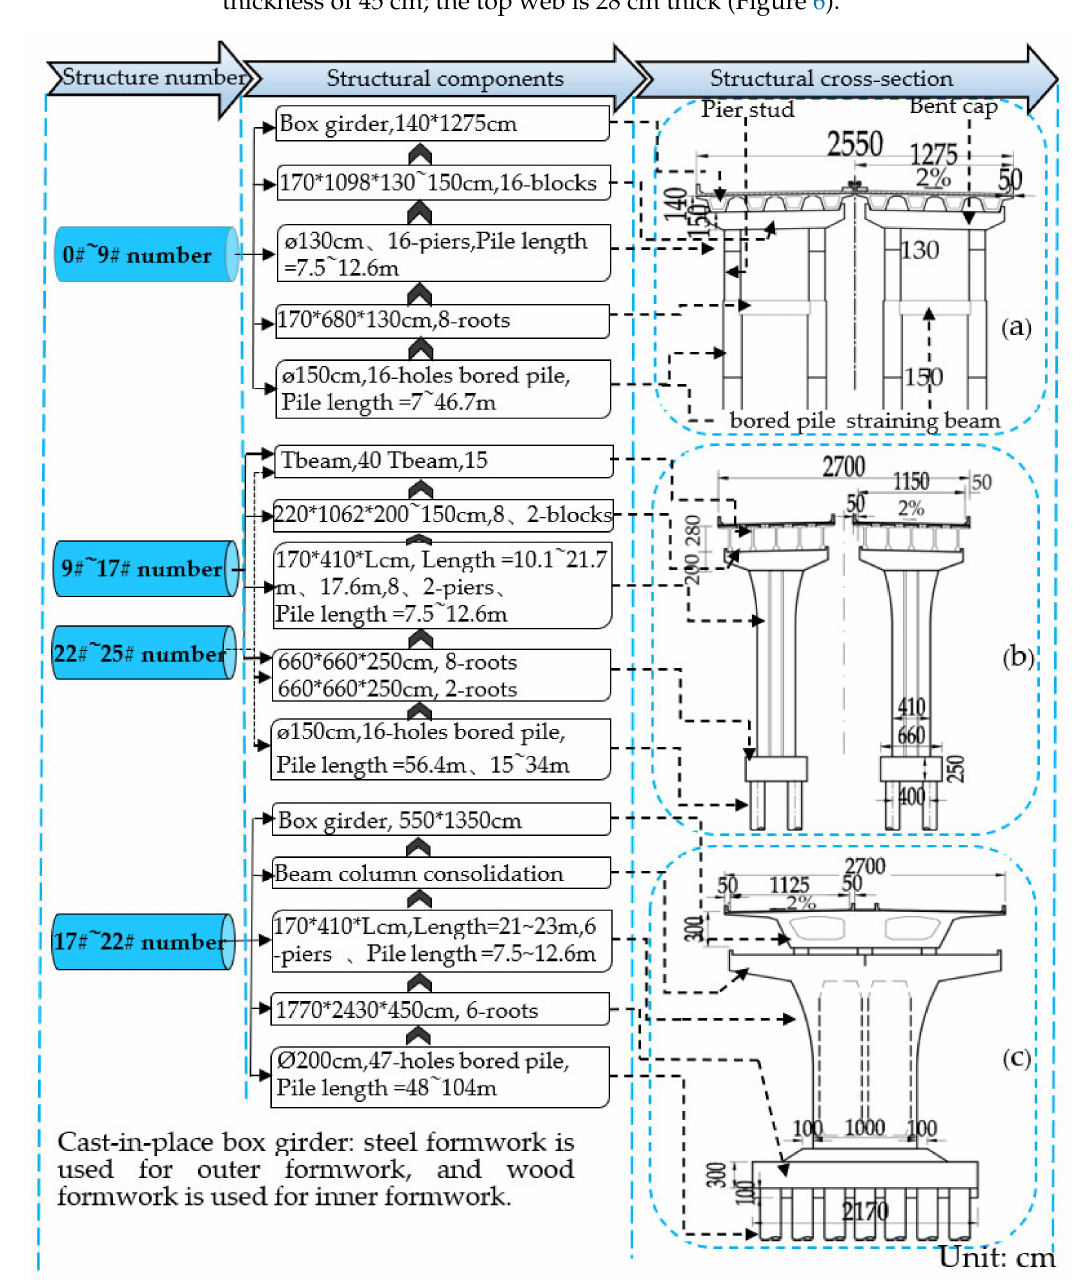
Figure 6. Structure distribution of cable-stayed bridge (0#~25#; cross-sectional view): ( a ) The 0#~9# structure is prestressed concrete small box girder; ( b ) The 9#~17# and 22#~25# structures are prestressed concrete T-beam; ( c ) The 17#~22# structure is large box beam of prestressed